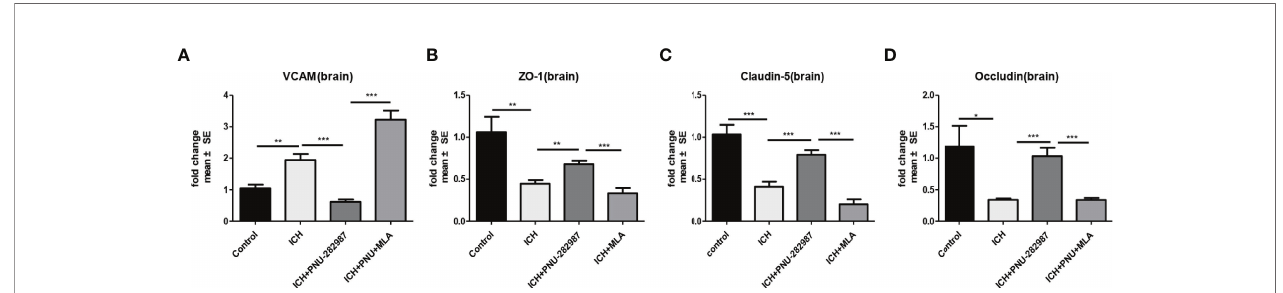
FIGURE 9 | a 7nAChR expression in endothelial cells promoted angiogenesis and alleviated the functional dysfunction of the blood – brain barrier after ICH. (A) PCR results indicated that PNU-282987 remarkably decreased the expression of VCAM. (B) The results of PCR demonstrated that PNU-282987 drastically increased the expression of ZO-1. (C) The results of PCR demonstrated that PNU-282987 drastically increased the expression of Claudin-5. (D) The results of PCR demonstrated that PNU-282987 drastically increased the expression of Occludin. n= 6 per group for echocardiography. Data are presented as mean ± SE; *p < 0.05; **P < 0.01; ***P < 0.0001. cartilage degradation and osteoarthritis pain, this protective effect of nicotine is associated with the inhibition of MMP-9 overexpression via the PI3K/Akt/NF-kB signaling pathway (50).